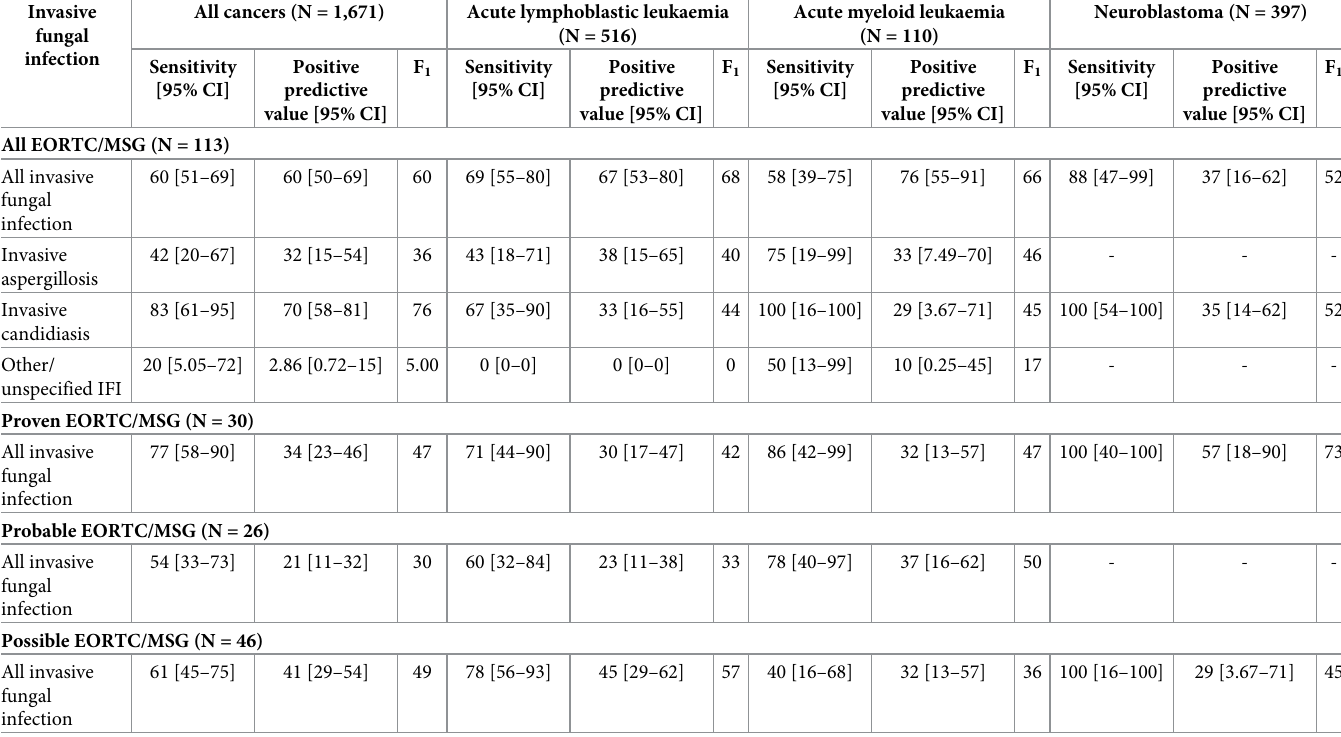
Abbreviations: CI, confidence interval; EORTC/MSG, European Organization for Research and Treatment of Cancer/Invasive Fungal Infections Cooperative Group and the National Institute of Allergy and Infectious Diseases Mycoses Study Group; IFI, invasive fungal infection. See S6 Table for performance classification statistics for the ‘modified possible’ and ‘treated for IFI’ classification.